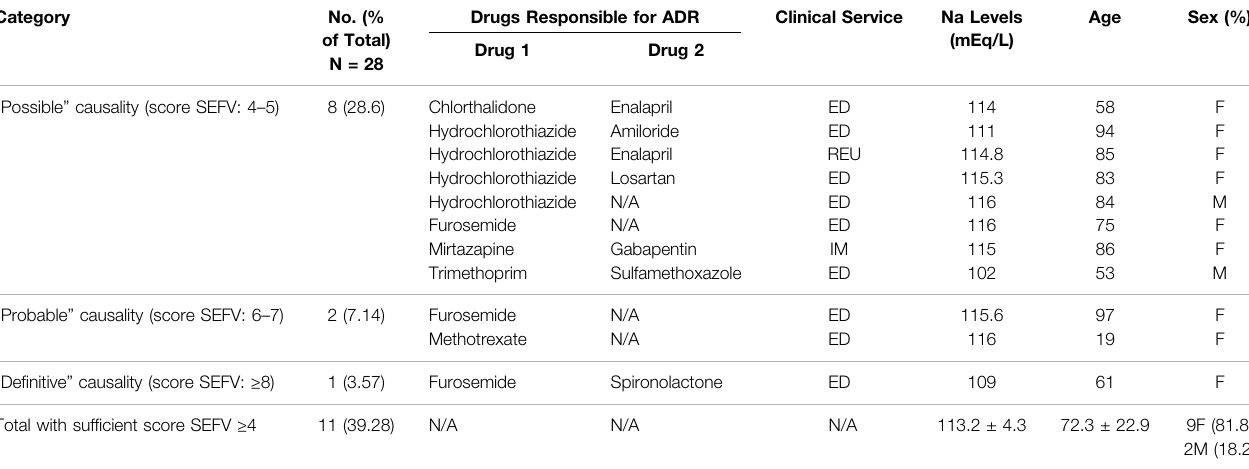
TABLE 4 | Cases of hyponatremia assessed using the SEFV Algorithm .